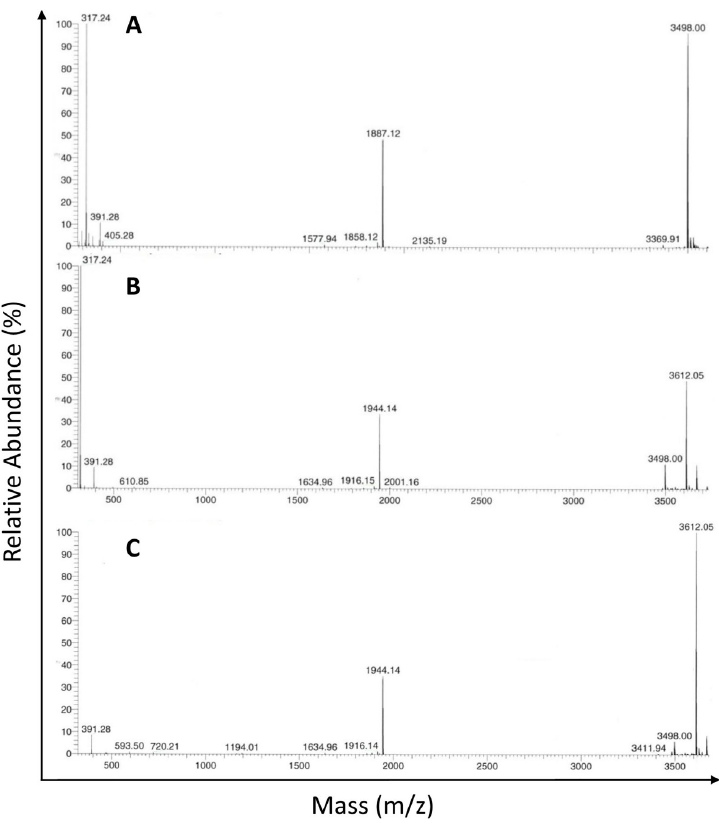
Fig 2. MALDI-TOP mass spectrum analysis revealed the lack of disulfide bond formation in bNK2A-C10C20 peptide. The original bNK2A-C10C20 peptide incubated with PBS (A), PBS followed by IAA (B), or TCEP followed by IAA at room temperature for 60 min and molecular masses of the peptide in each sample were analyzed using Q Exactive Hybrid Quadrupole-Orbitrap Mass Spectrometer.